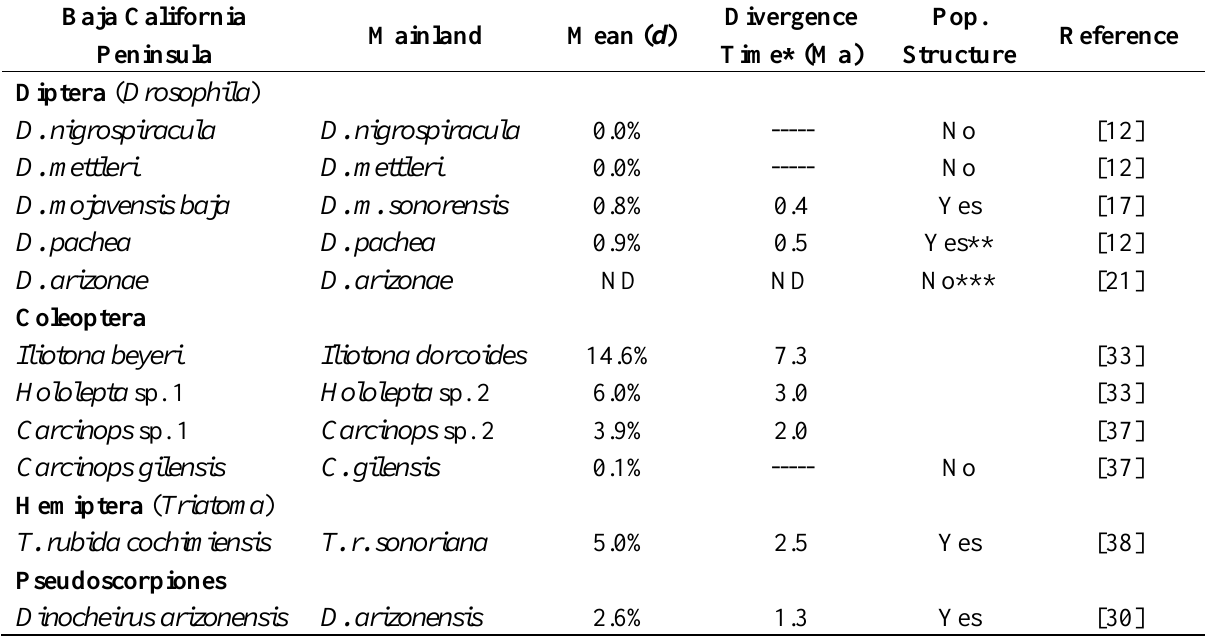
Table 1. Summary of Kimura 2-parameter mean genetic distances ( d ), estimated divergence times in millions of years (Ma), and population structure between